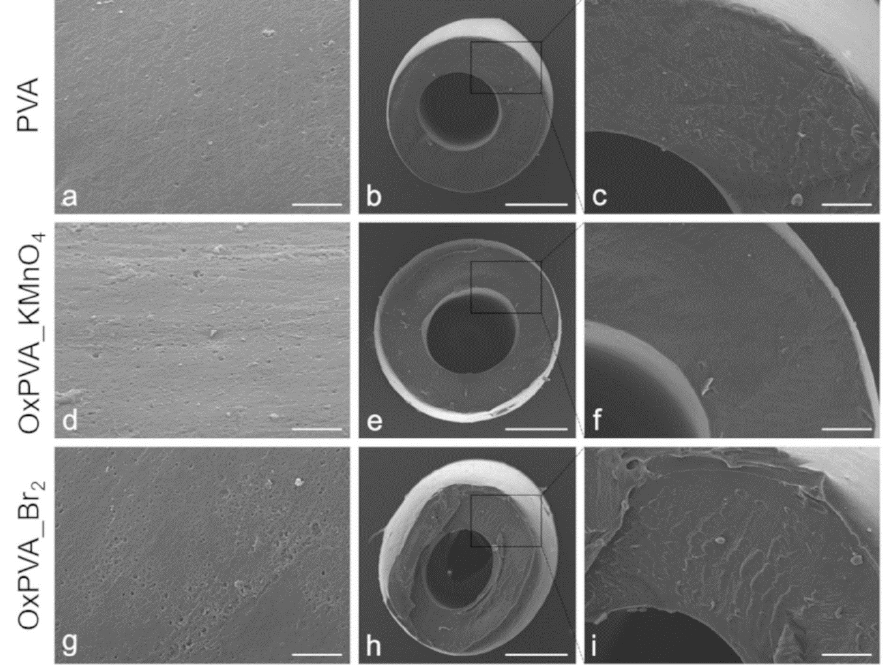
Figure 3. Ultrastructural analysis . SEM micrographs of crosslinked PVA-based nerve guidance conduits. ( a , d , g ) Side view and ( b , c , e , f , h , i ) transversal cross-sections of tubular scaffolds. Scale bars: ( a , d , g ) 10 µm; ( b , e , h ) 500 µm; ( c , f , i ) 100